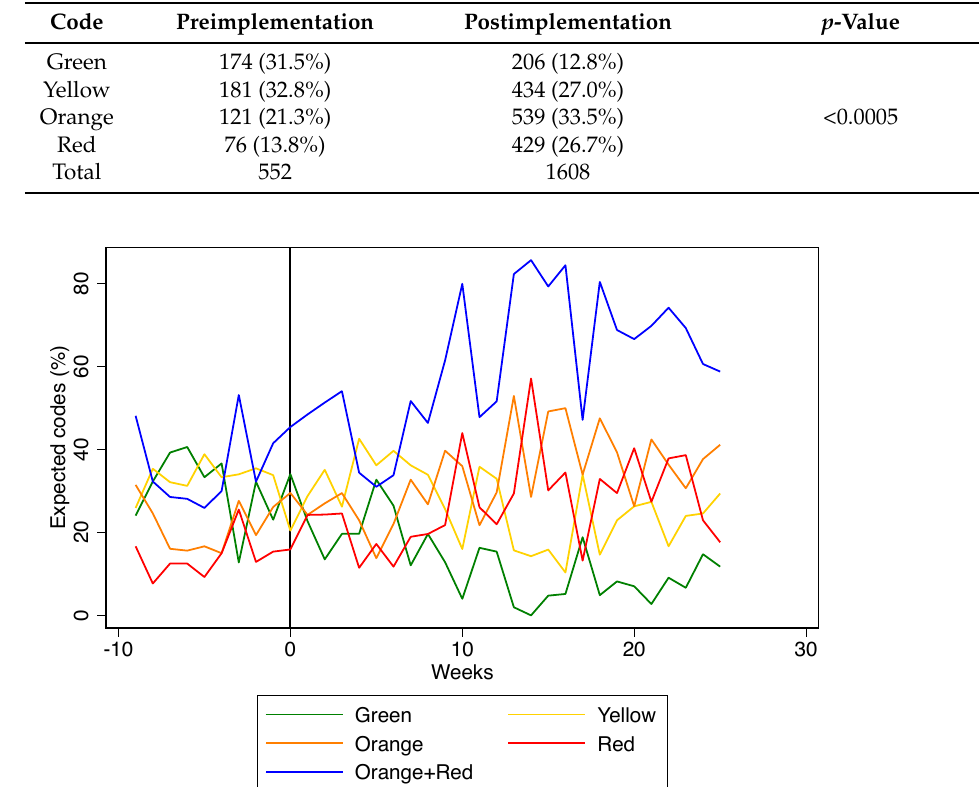
Figure 2. Proportion of expected triage codes before and after the implementation of the SATS (black